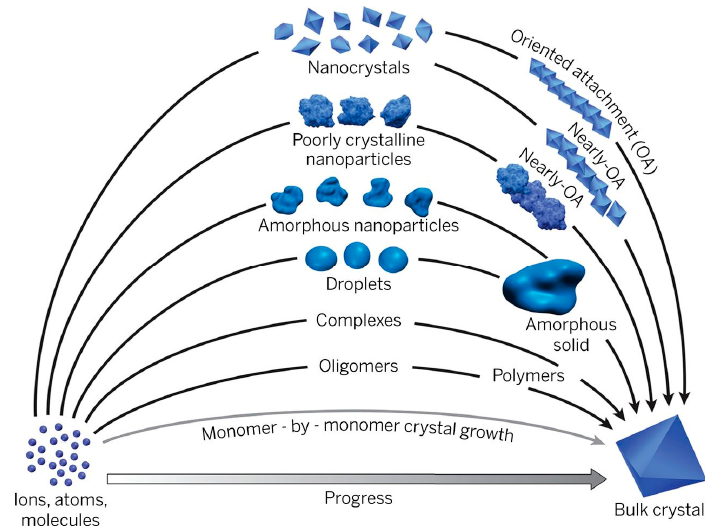
Figure 1. Schematic elucidation of classical (monomer-by-monomer crystal growth) and “nonclassical” crystallization pathways. Reproduced with permission from the American Association for the Advancement of Science in Reference [14].